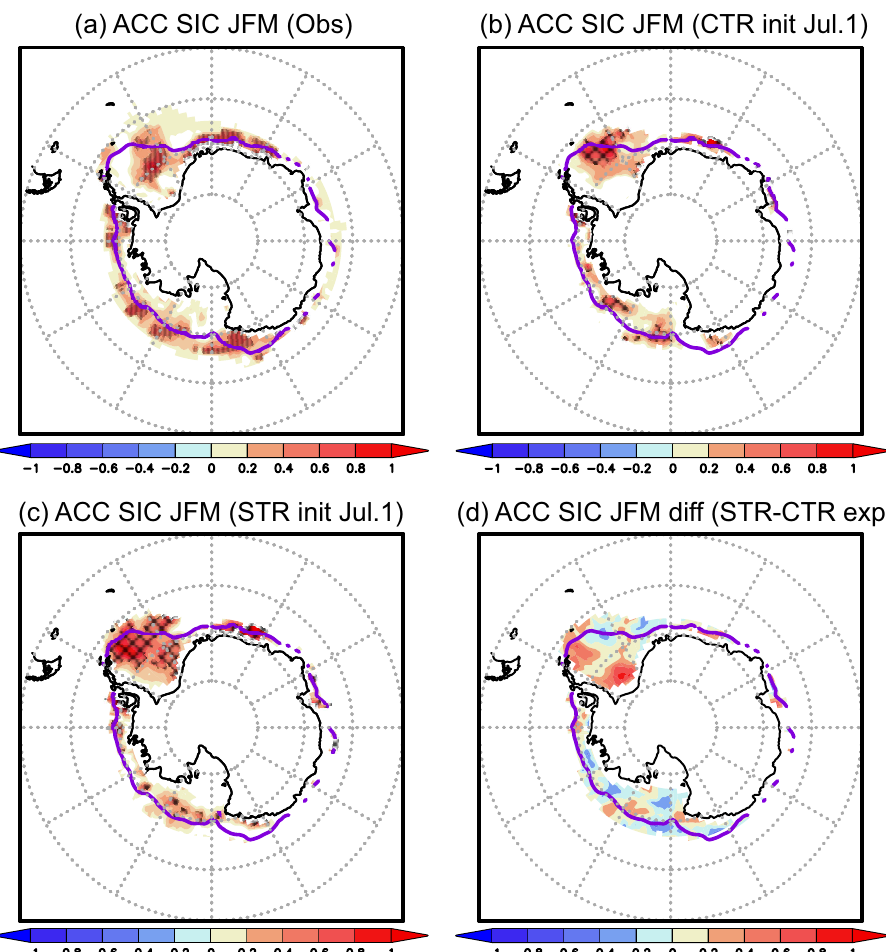
Figure 4. ( a ) ACCs between the observed SIC anomalies in June and the anomalies in January–March of the following year. Dots indicate correlations that are statistically significant at 90% confidence level using the two- tailed Student’s t -test. Purple lines represent sea-ice edges with the SIC values of 15% from the observation data. ( b ) Same as in ( a ), but for the January–March ACCs between the observed SIC anomalies and the SIC anomalies predicted from July 1st in the CTR experiment. Hatches indicate correlations above the persistence values that are statistically significant at 90% confidence level using the two-tailed Student’s t -test. ( c ) Same as in ( b ), but for the January–March ACCs between the observed SIC anomalies and the SIC anomalies predicted from July 1st in the STR experiment. ( d ) Differences in the January–March ACCs between the STR and CTR experiments, i.e., ( c )–( b